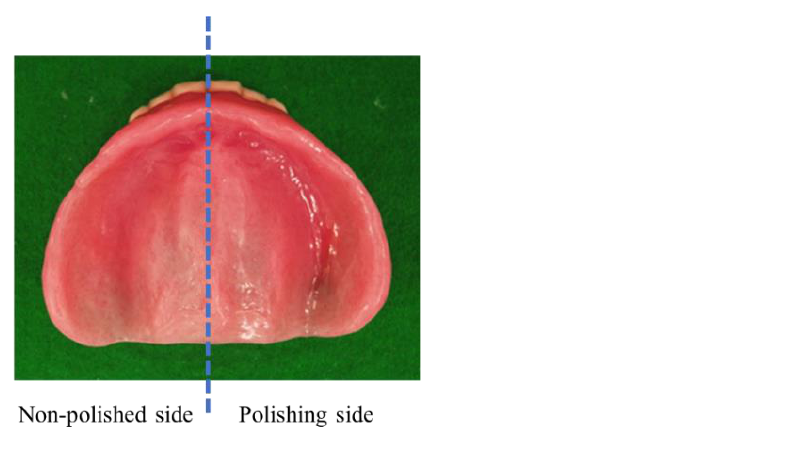
Figure 5. The mucosal surface of a new denture with the right half polished and the left half not polished.